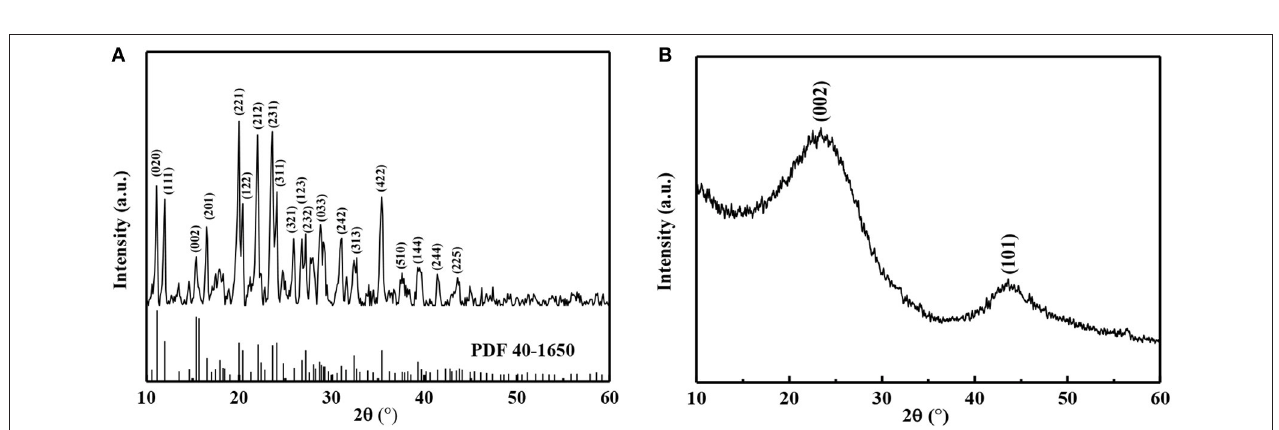
FIGURE 5 | XRD patterns of (A) expired oxytetracycline and (B) expired-oxytetracycline-derived carbon powders.